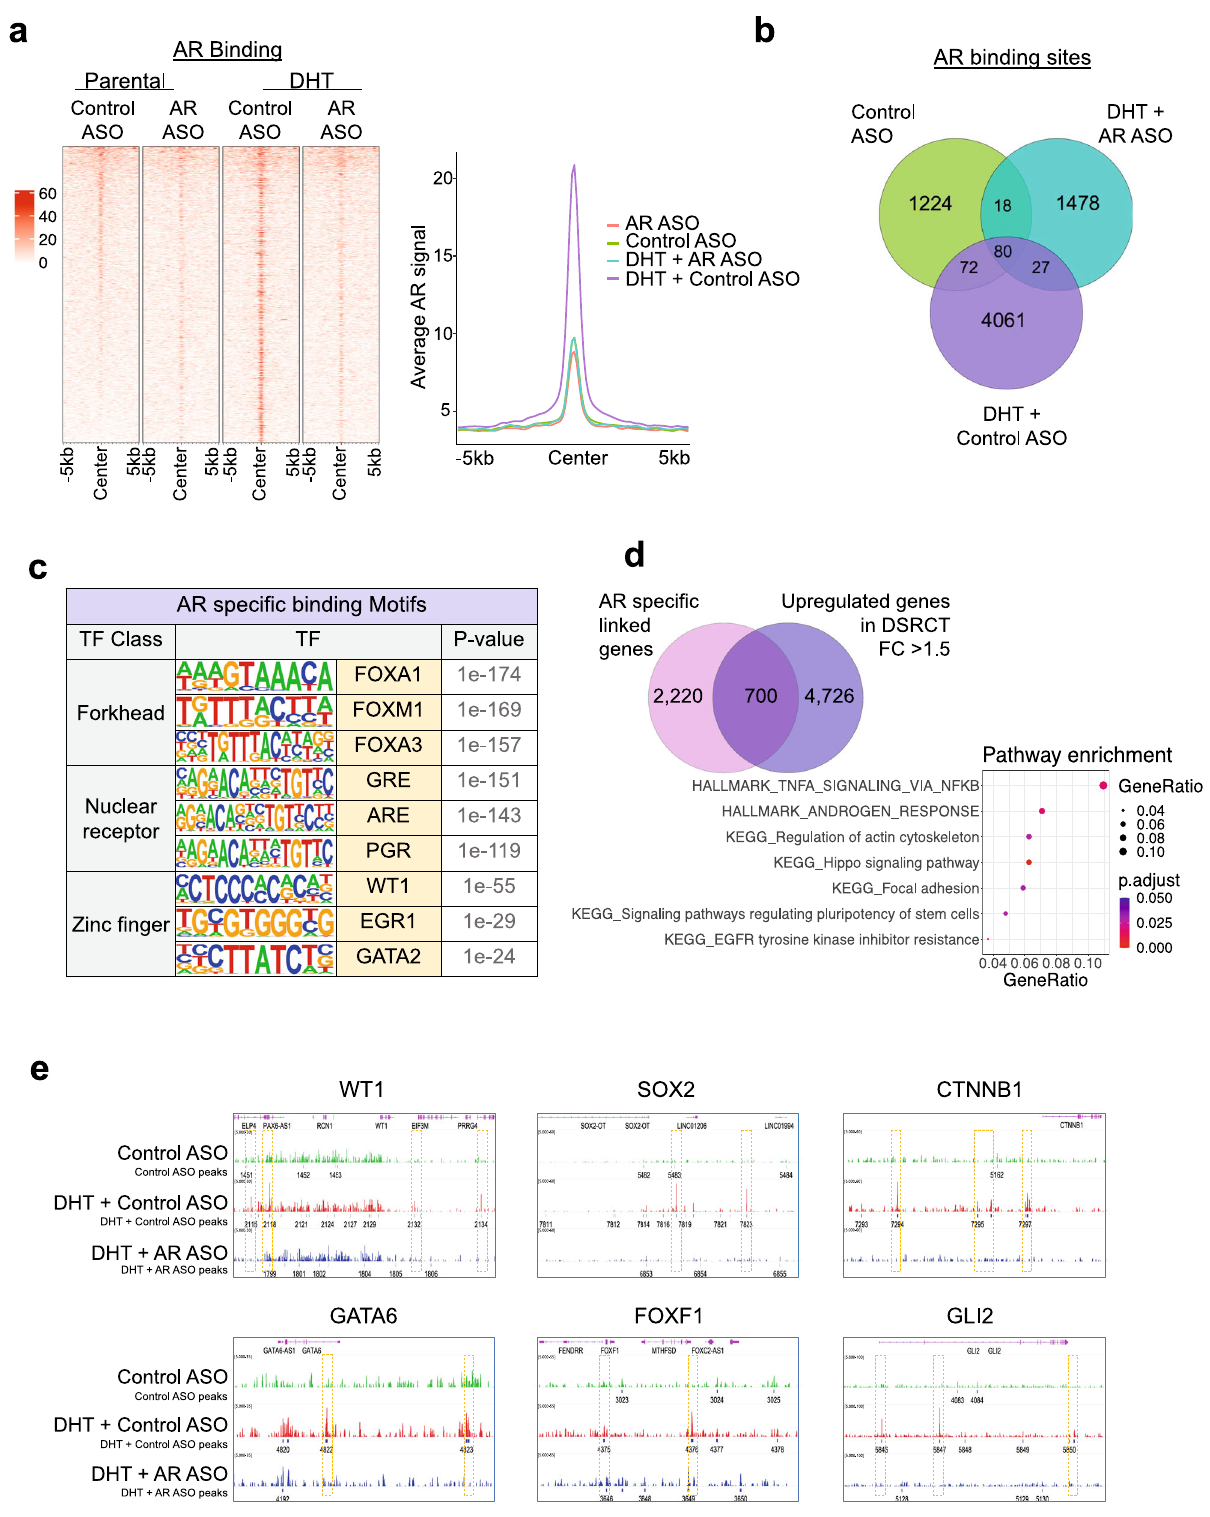
Fig. 7 AR binding in JN-DSRCT cells. a Heatmaps (left panels) and average intensity curves (right panels) of ChIP-seq reads (RPKM; reads per kilobase of transcript per million mapped reads) for AR binding regions. AR binding sites are shown in a 10-kb window (centered on the middle of the binding site) in Control ASO, AR-ASO, DHT + Control ASO, and DHT + AR-ASO samples. b Venn diagram showing the overlap of all AR peaks between Control ASO, DHT + Control ASO, and DHT + AR-ASO samples to identify the AR-unique or shared binding sites. c List of enriched transcription factor (TF) motifs in AR-speci fi c binding sites. Motifs are identi fi ed using HOMER (Binomial test). d Dot plot showing signi fi cantly enriched pathways for AR-speci fi c binding sites. Dot size represents gene ratio, and colors represent adjusted p values (Fisher ’ s exact test). e IGV images showing enrichment of AR peaks around WT1 , SOX2 , CTNNB1 , GATA6 , FOXF1 , and GLI2 genes using aggregate ChIP-seq pro fi les of Control ASO, DHT + Control ASO, and DHT + AR-ASO samples.